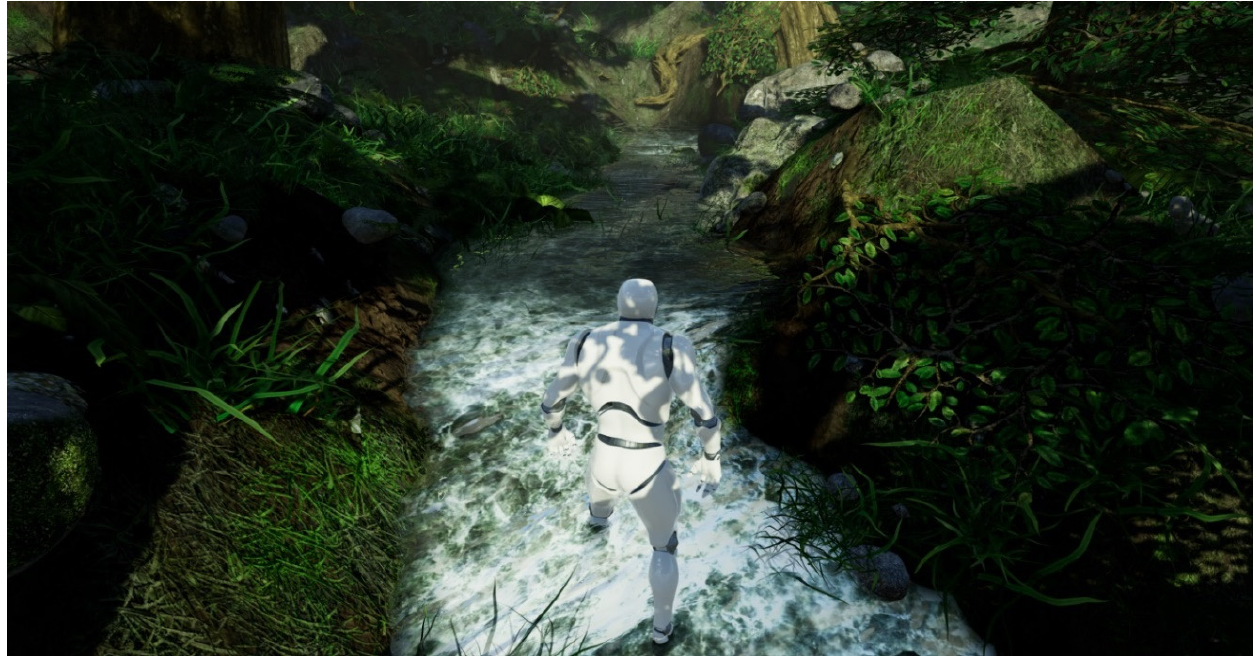
Figure 2. Virtual spatial experience from a flowing body of water in a forest landscape (own illustration by Dennis Edler and Timo Wiedenlübbert).